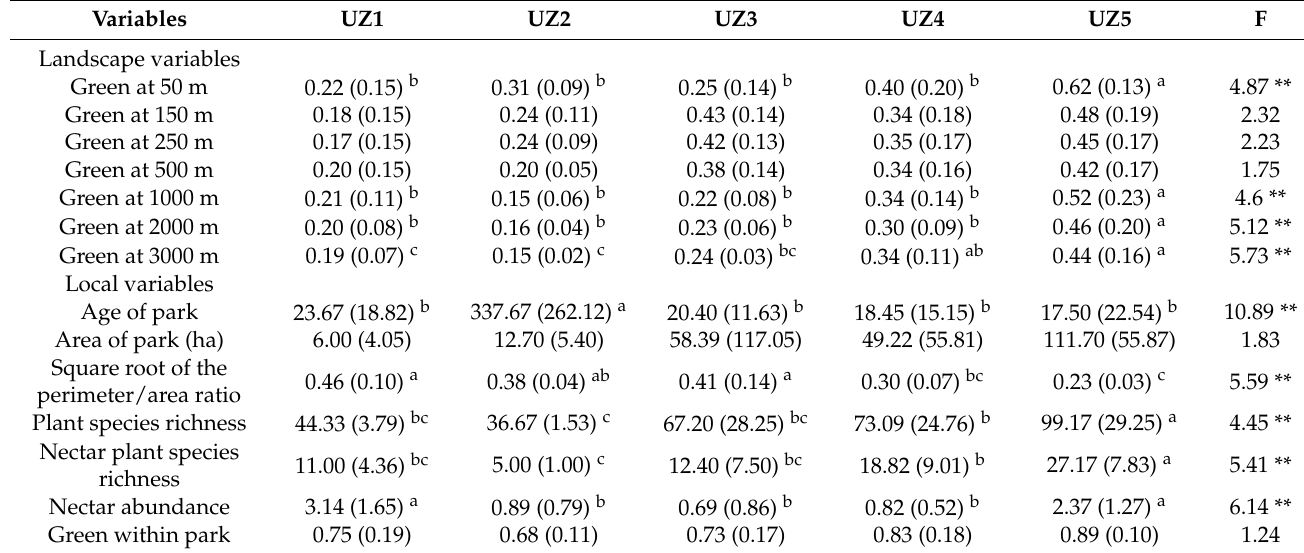
Table A3. Comparisons of environmental variables measured among urban zones were performed with ANOVA, and LSD test was used for multiple pairwise comparisons (letters indicate significant differences based on multiple pairwise comparisons; **: p < 0.01).